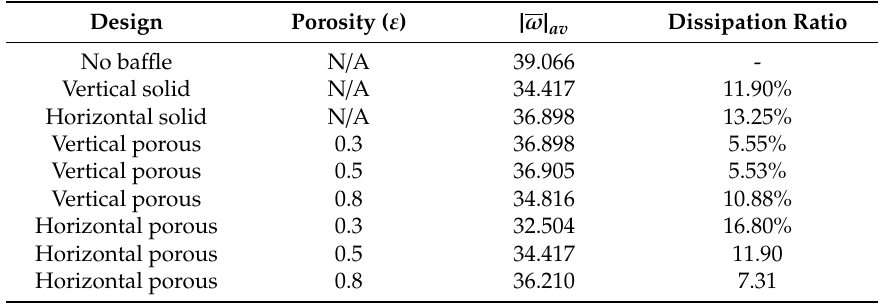
Table 4. Comparison of vortex damping performance of each design in Figure 9. N / A—not applicable.